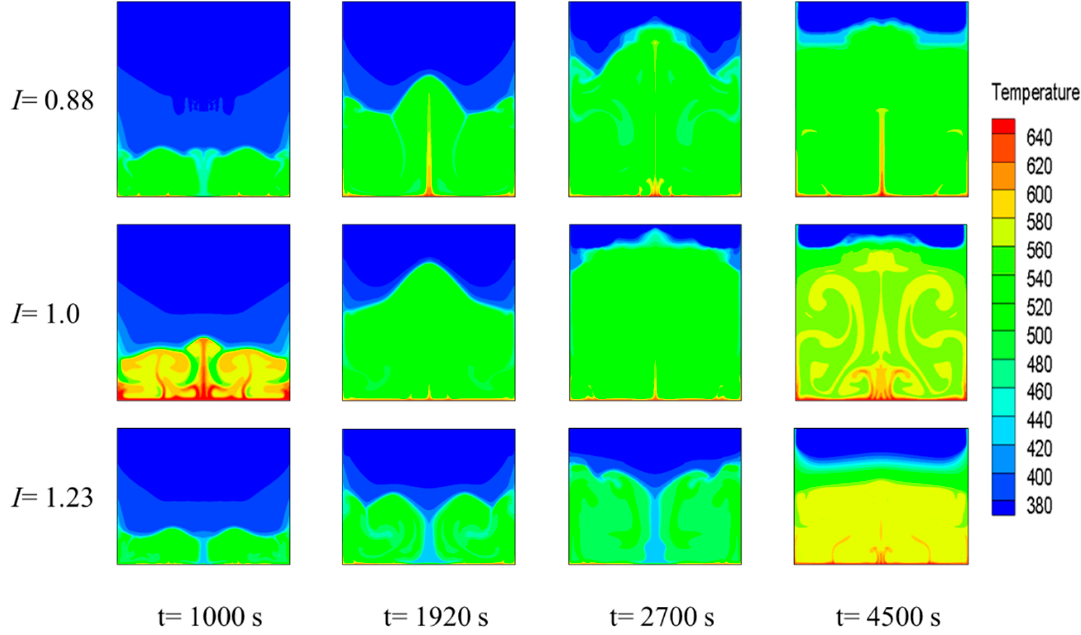
Figure 10. Temperature fields for the melting process under different I values.